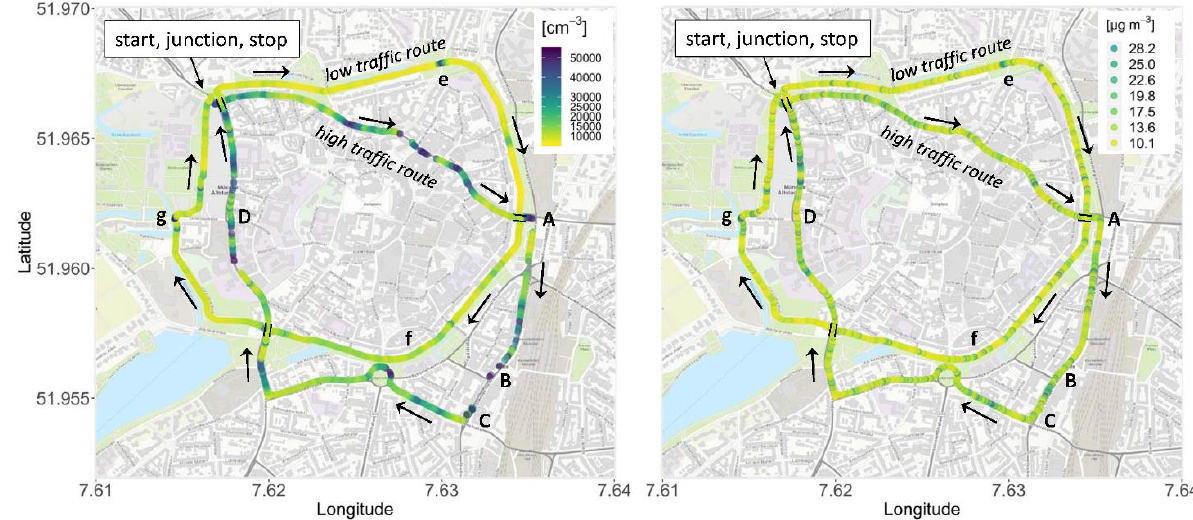
Figure 3. Color-coded maps of PN ( left panel ) and PM10 ( right panel ) concentrations during ride 3 on 31 October 2019. Start and end point of both routes (high traffic and low traffic) around the city center are in the NW corner; this is also the junction point between the routes. Points of interest and for orientation are A: Eisenbahnstraße; B: front of main train station; C: Hafenstraße; D: Schlossplatz; e: Neubrückenstraße.; f: Ludgeriplatz; g: Hüfferstraße.